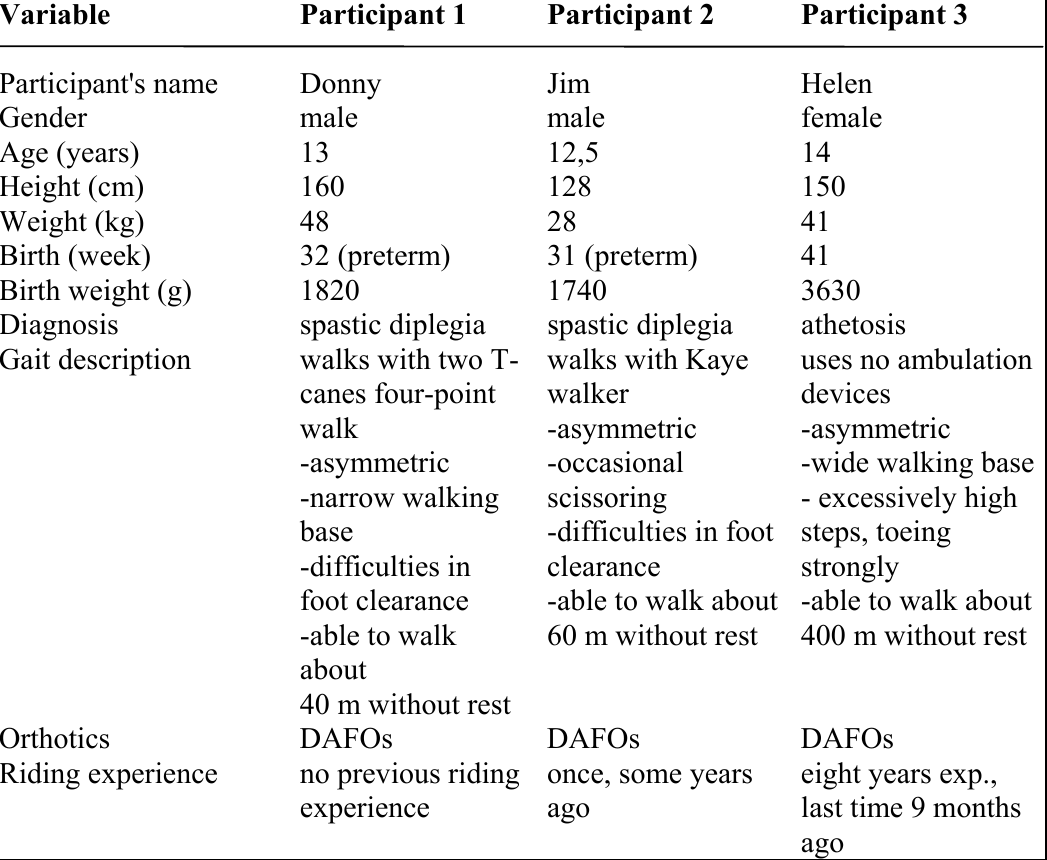
Participants’ data (DAFO’s = dynamic ankle foot orthoses)